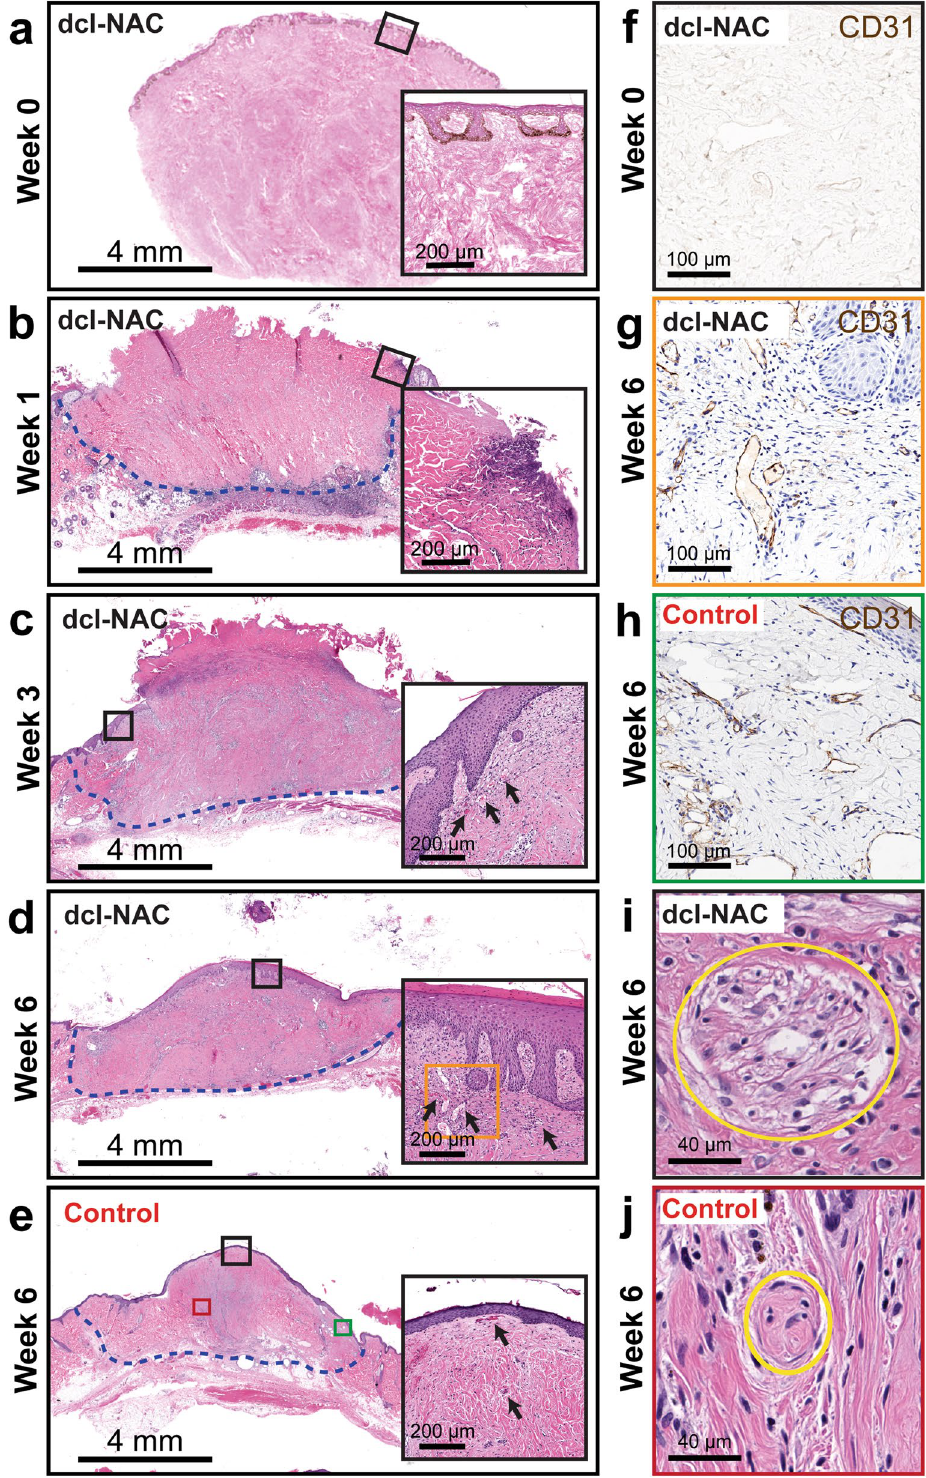
Figure 3. Histological analysis of re-cellularized dcl-NACs and controls. ( a – e ) H&E-stained sections from the sagittal midline of dcl-NACs ( a ) prior to engraftment and excised after ( b ) 1 week, ( c ) 3 weeks, ( d ) 6 weeks post-engraftment, and of ( e ) an intact, non-decellularized native NHP control 6 weeks post-engraftment. Black boxes are magnified in insets highlighting surface margin including epidermis, and black arrows point to vasculature; dashed blue line marks graft-host margin. ( f – h ) CD31 staining (dark brown) for vasculature in ( f ) a non-engrafted dcl-NAC, ( g ) a dcl-NAC 6-weeks post engraftment (adjacent section magnified from orange box in ( d )), and ( h ) an intact, non-decellularized native NHP control at week 6 (adjacent section magnified from green box in ( e )). ( i , j ) Yellow circles surround nerves identified in ( i ) a dcl-NAC and in ( j ) an intact, non-decellularized native NHP control (magnified from the red box in e ) at week